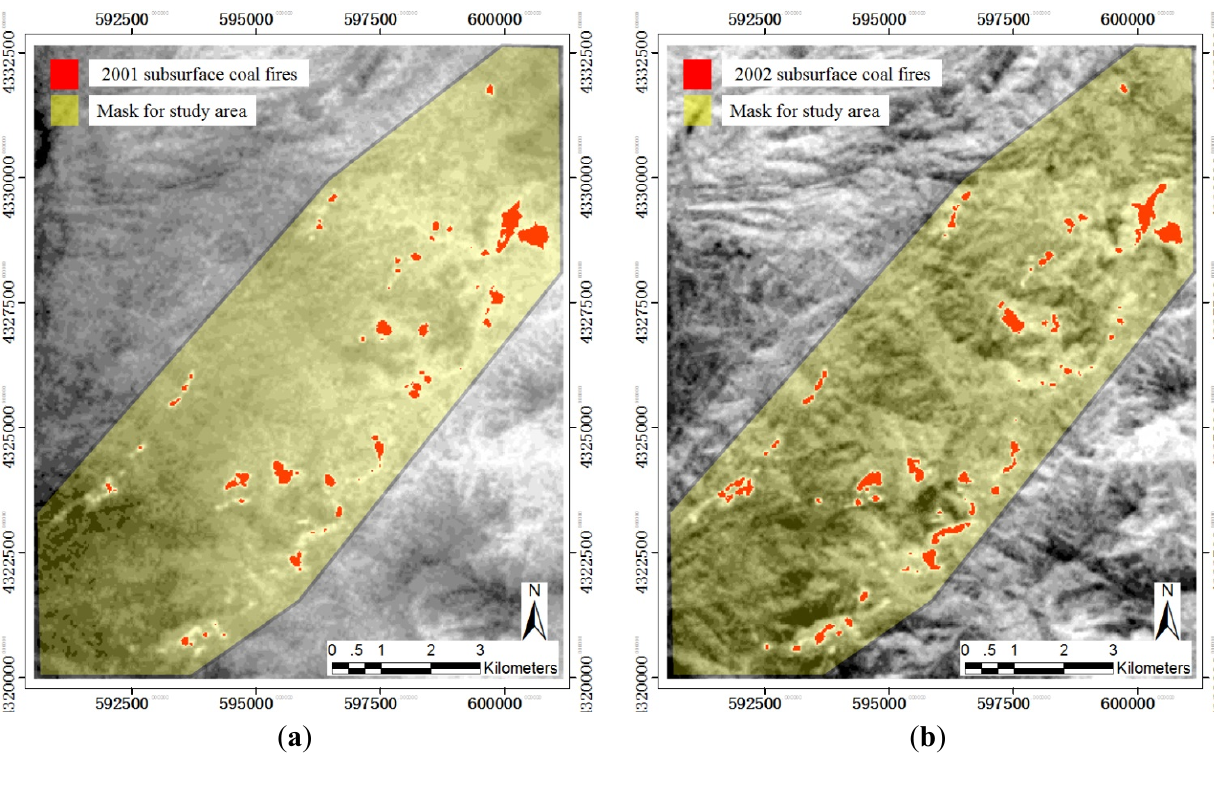
Figure 5. Subsurface coal fires extracted from the ETM+ thermal band 6 data of 2001, 2002, and 2007. ( a ) thermal anomalies related subsurface coal fires of 2001; ( b ) thermal anomalies related subsurface coal fires of 2002; ( c ) thermal anomalies related subsurface coal fires of 2007; ( d ) multi-layer thermal anomalies related subsurface coal fires of 2001, 2002, and